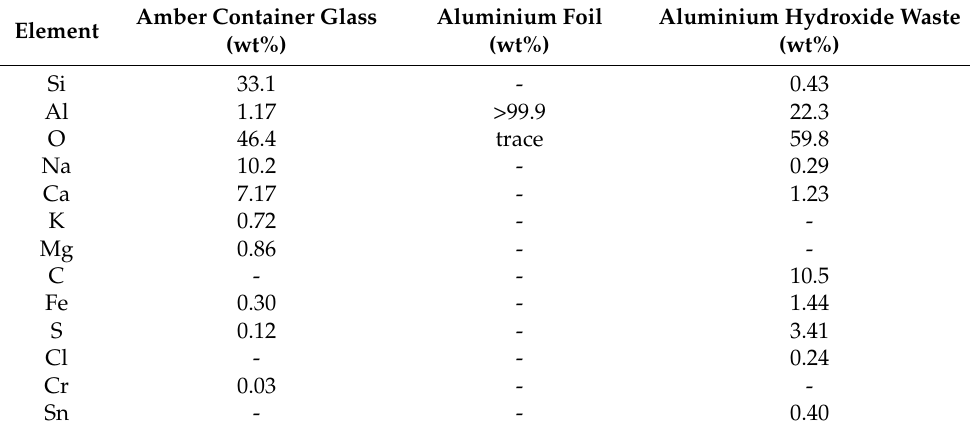
Table 1. Compositions of waste container glass, aluminium foil and amorphous aluminium hydrox- ide